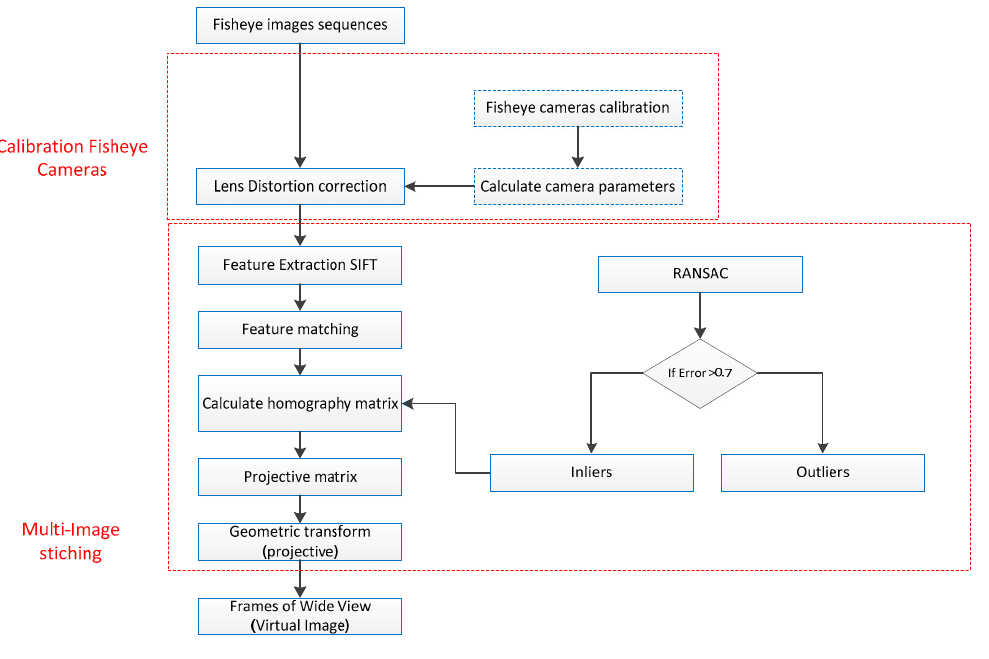
Figure 6. Workflow of the proposed raw image mosaicking.